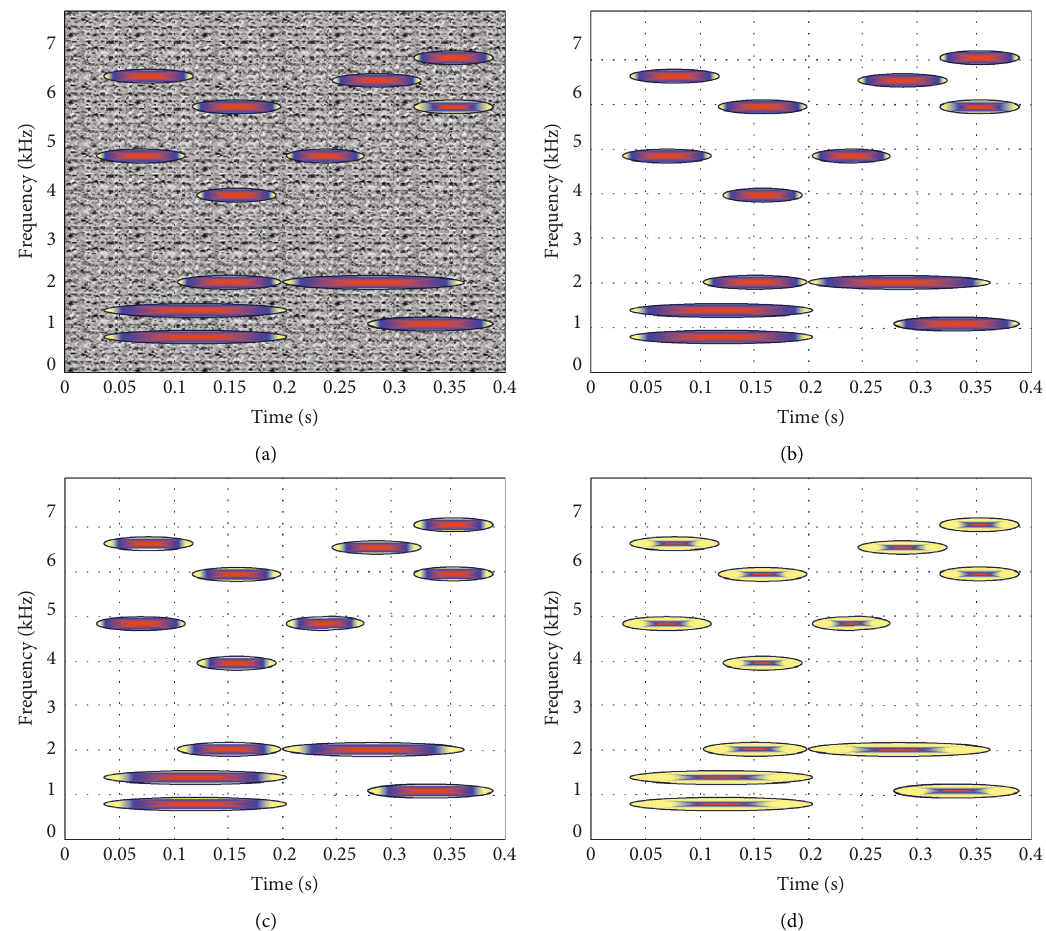
Figure 8: Time-frequency distribution of STFTand its combination. (a) STFT, (b) STFT-WVD, (c) STFT-PWVD, and (d)